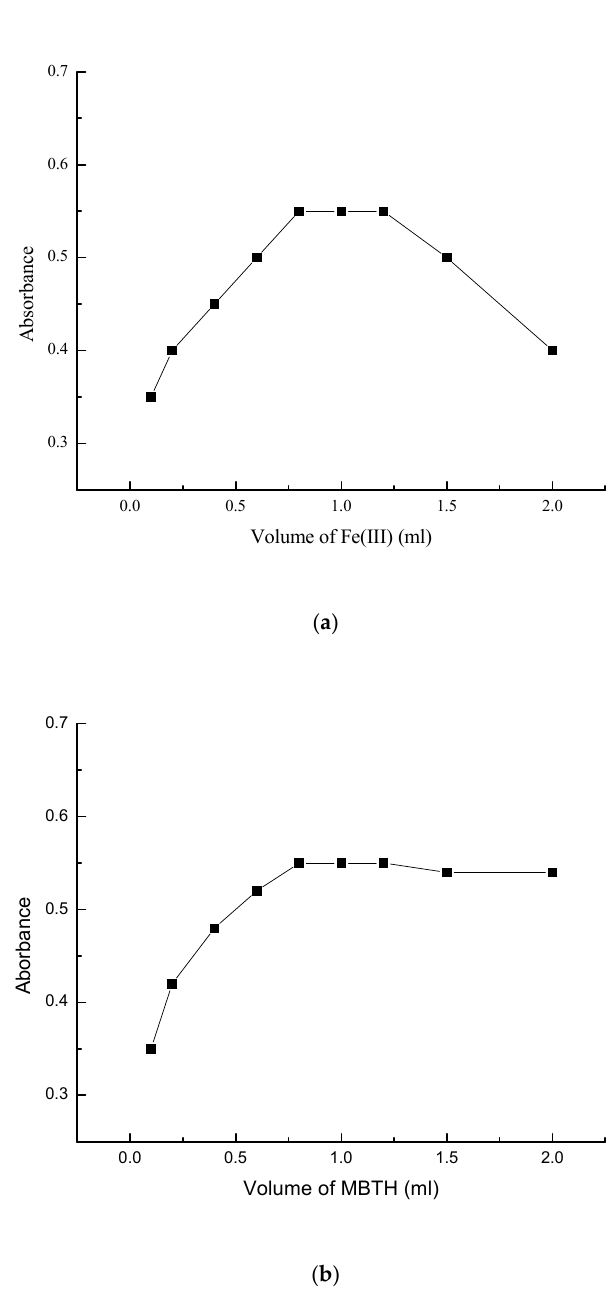
Figure 6. E ff ect of concentration of ( a ) Fe (III) and ( b ) Figure 6. Effect of concentration of ( a ) Fe (III) and ( b ) MBTH.